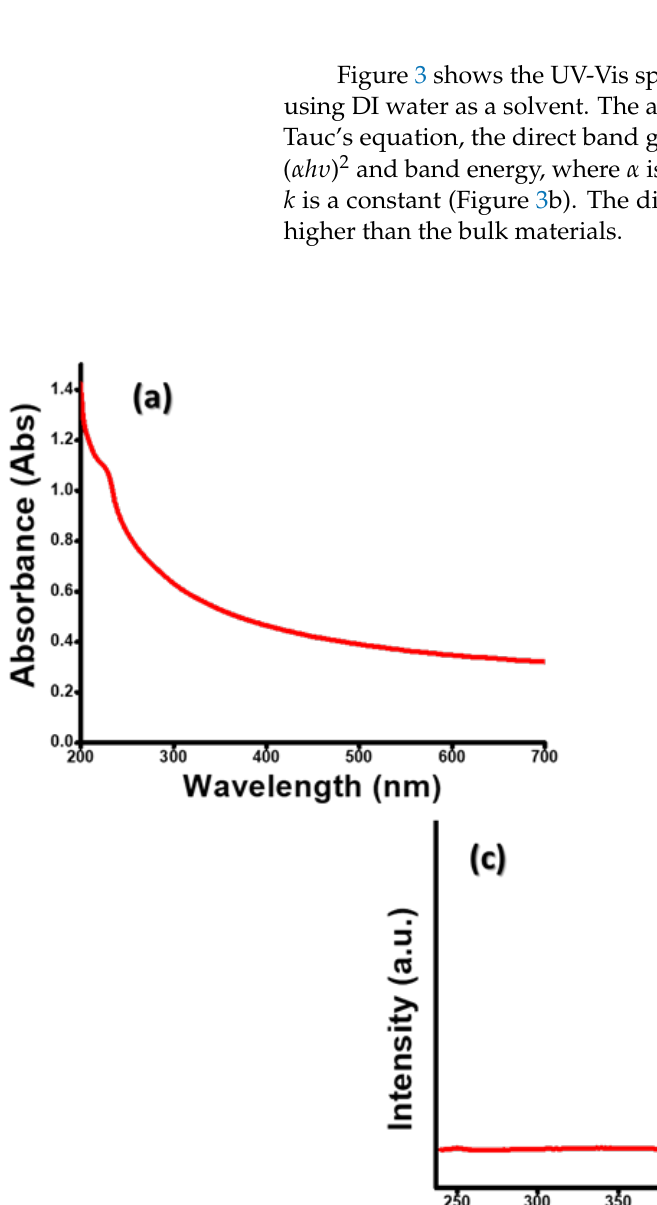
Figure 2. HR-TEM images of ( a ) Gd 2 O 3 NPs; ( b ) SAED pattern of Gd 2 O 3 NPs; ( c ) HR TEM images of Gd 2 O 3 NPs; and ( d ) NPs size distribution.